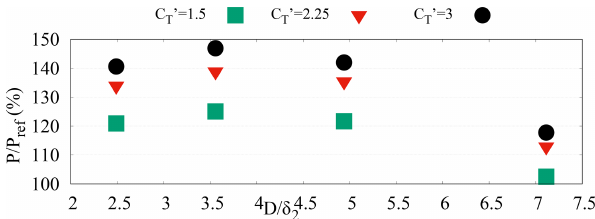
Figure B2. Power gains versus the ratio D/δ 2 of the turbine di- ameter to the boundary layer momentum thickness for turbines with control rotors tilted by ϕ = 30 ◦ operated at selected C (cid:48) H = 500m